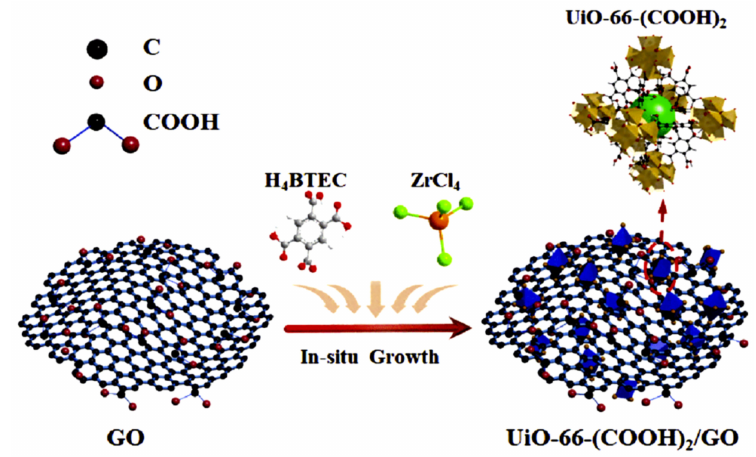
Figure 15. In situ synthesis of the UiO-66-(COOH) 2 -GO composite. Reprinted with permis- sion from [328].